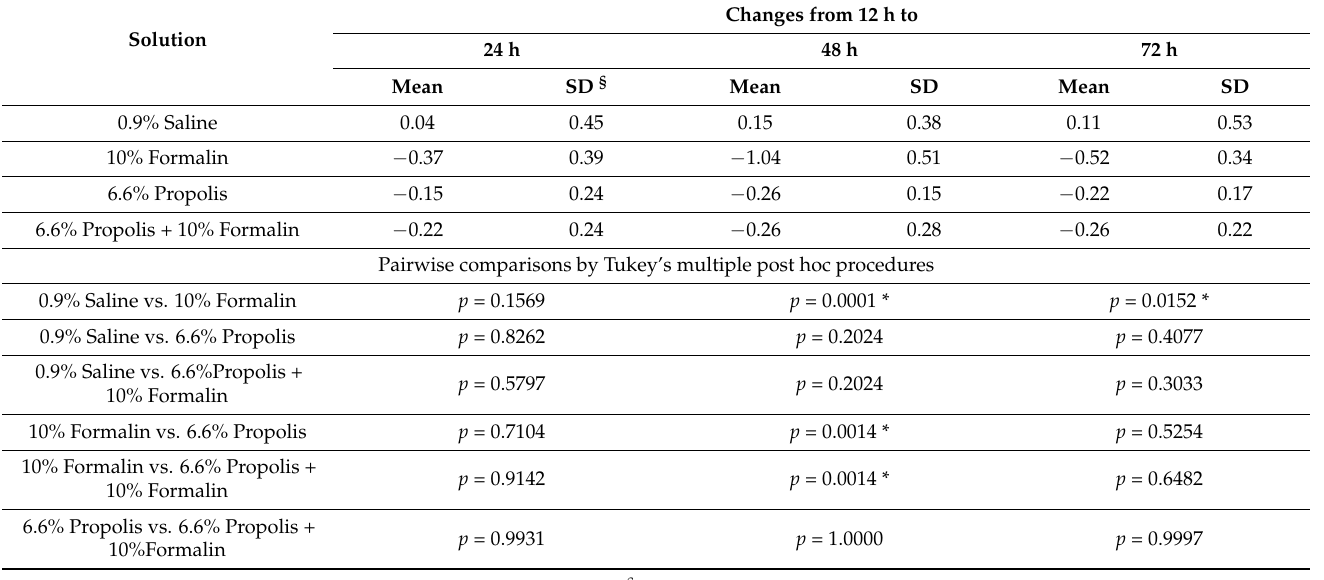
Table 4. Comparison of fixative ability of different solutions with change in scores from 12 h to 24, 48, and 72 h treatment